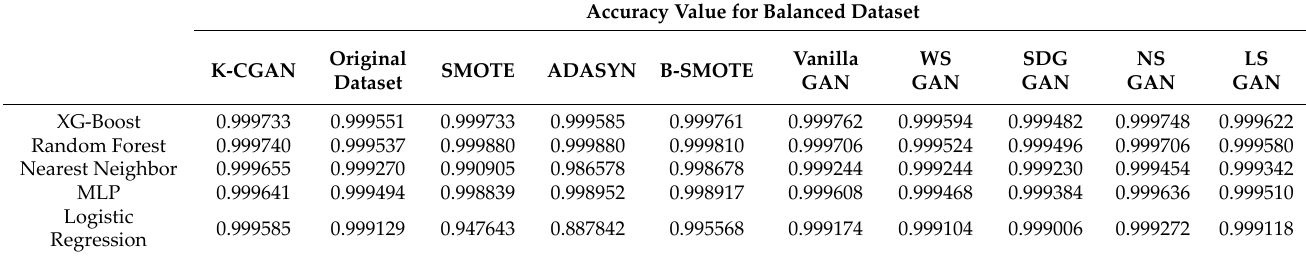
Table 11. Accuracy values for classification methods. Accuracy Value for Balanced Dataset